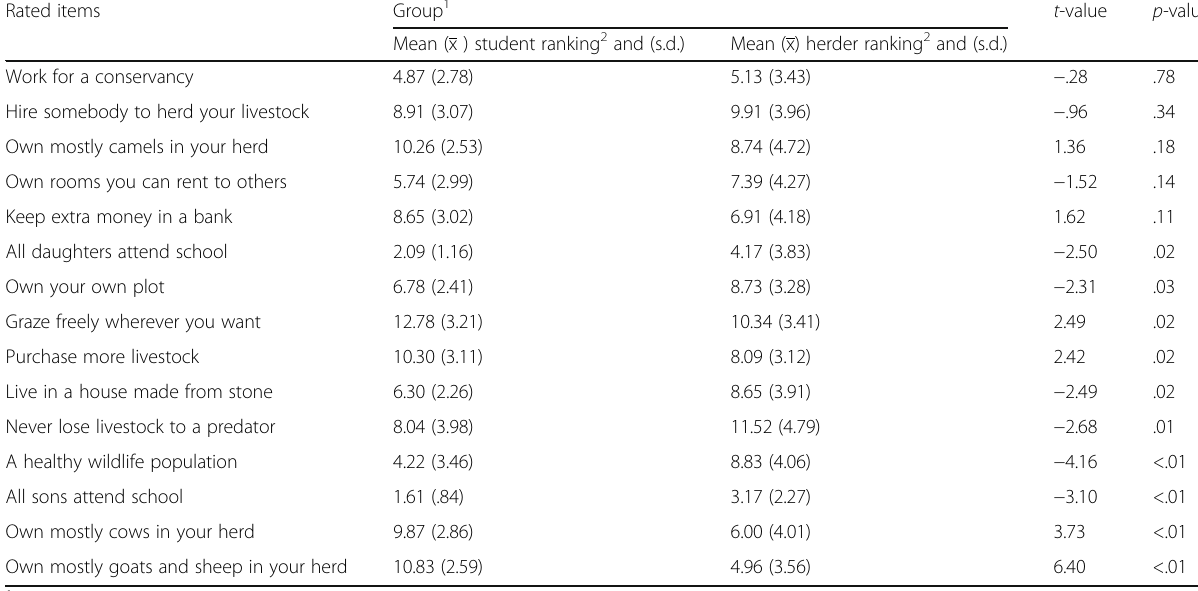
Table 3 Differences between herders and students on 15 possible future outcomes, in order of statistical significance